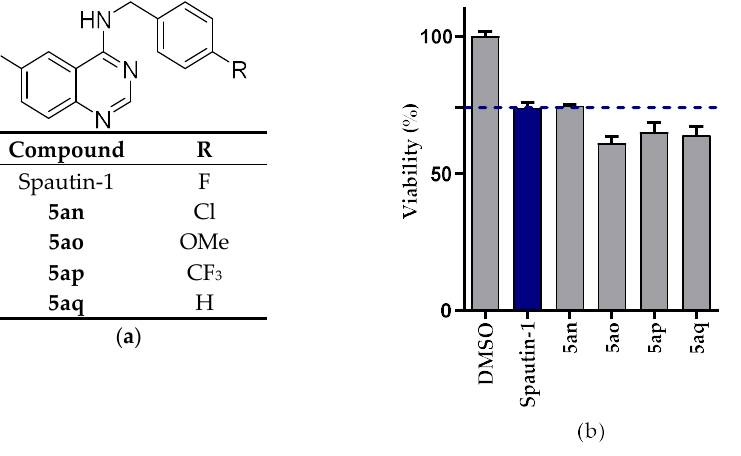
Figure 6. ( a ) Substituent effect on the para position of the phenyl group; ( b ) viability assay (5µM) with Spautin-1 as reference.